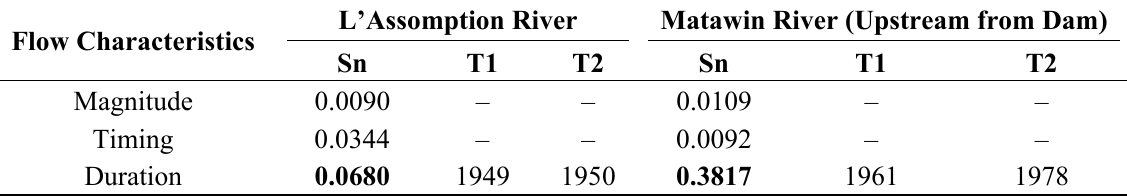
Table 4. Comparison of the stationarity of annual daily minimum flows in natural rivers using the Lombard method (1930–2010).